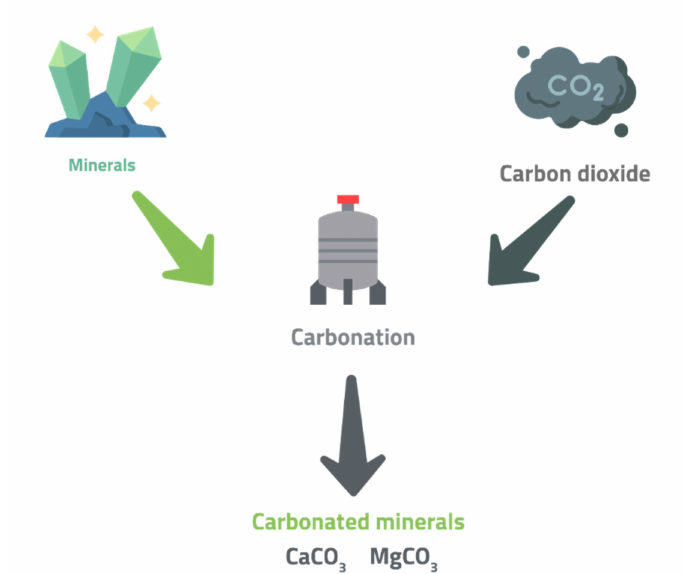
Figure 3. Principles of Direct Carbonation.